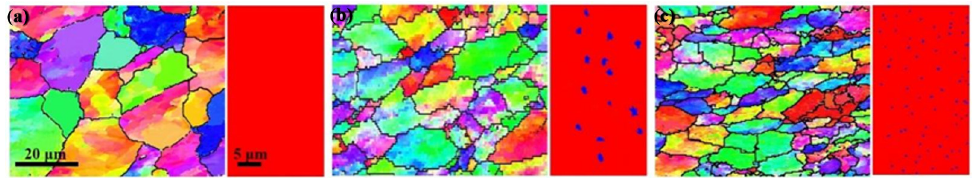
Figure 1. EBSD IPF and phase maps of three tested samples: ( a ) pure W, ( b ) sintered W ‐ 1.5ZrO 2 composites, ( c ) swaged W ‐ 1.5ZrO 2 composites.